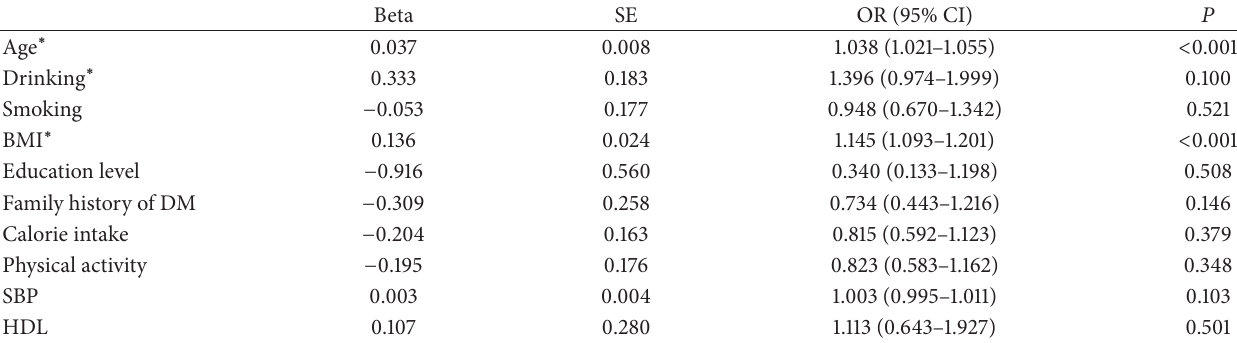
Table 4: Multivariate logistic regression analysis of diabetes (drinking as a single variable).